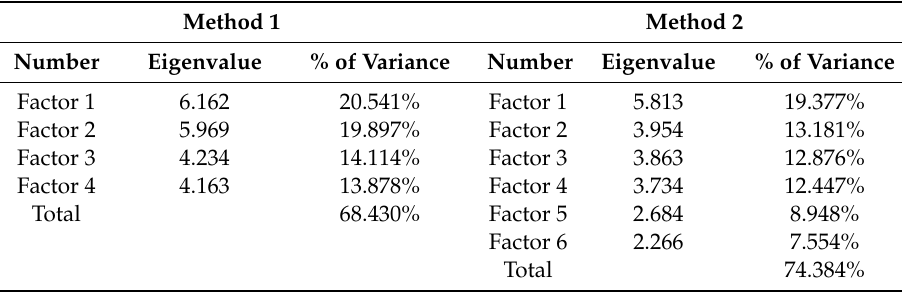
Table 7. Eigenvalues and extraction of squared loadings